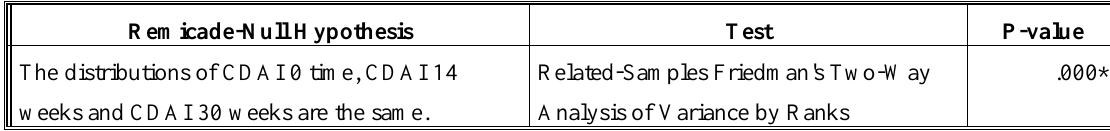
Table 6-A. The difference in CDAI scores across three measures before (baseline) and after Remicade treatment (14 weeks and 30 weeks post-therapy).